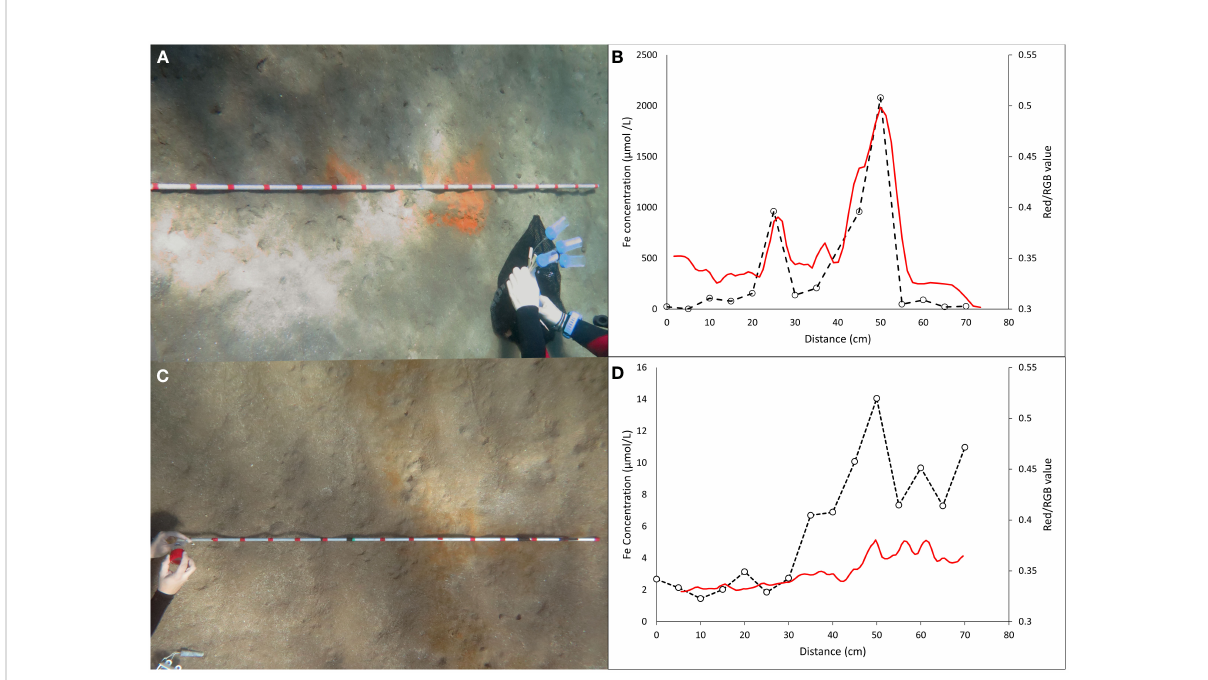
FIGURE 6 Photographs taken by the authors showing the line transect method for collecting pore water before (A) and after (C) a storm event. Collections were made at the red marks which are 5 cm apart. Fe concentration in the pore water and the intensity of redness as function of the sampling position in the sediment patch before (B) and after (D) a storm